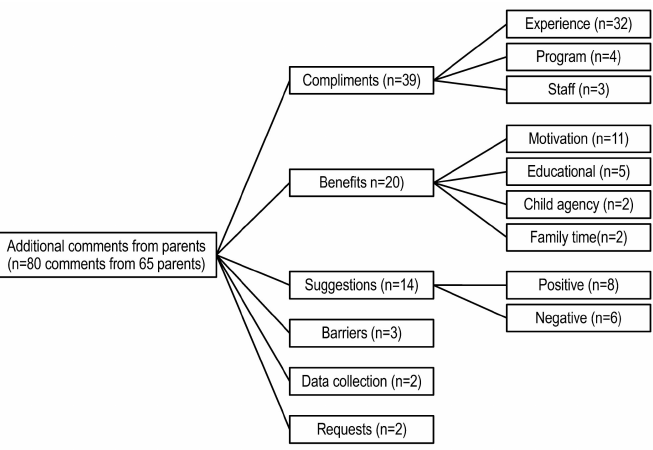
Figure 2. Parent comments on the Butterfly Girls